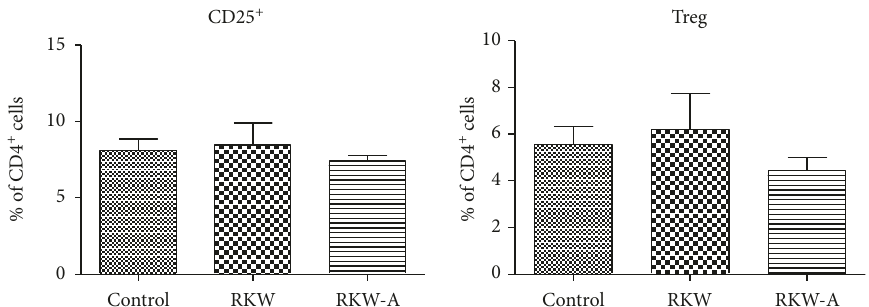
Figure 3: Treg cells in peripheral blood. Analysis was performed in the o ff spring of mothers fed during pregnancy and lactation with water (RKW) or hydroalcoholic (RKW-A) extract of Rhodiola kirilowii.